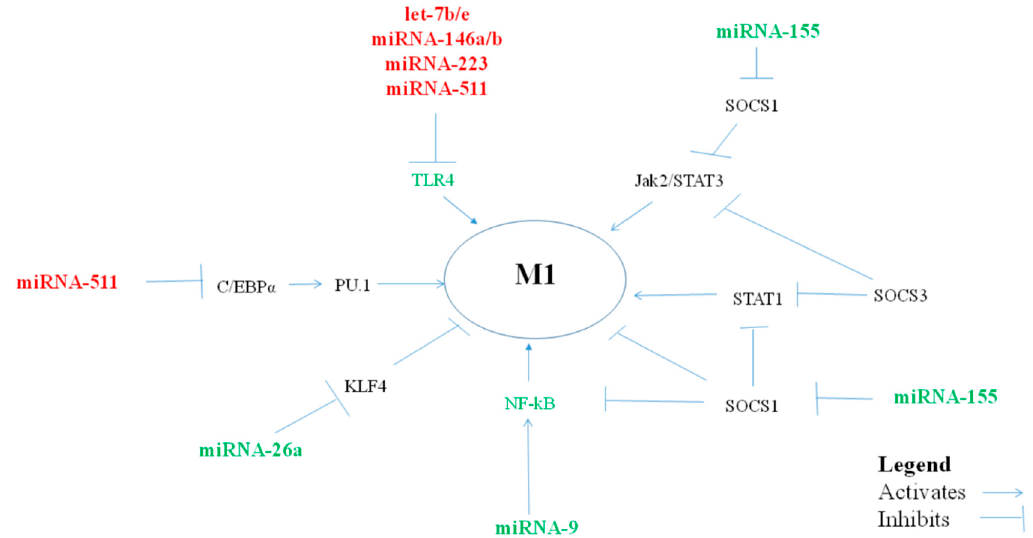
Figure 1. miRNAs, via their targets, influence pro-inflammatory M1-macrophage polarization.